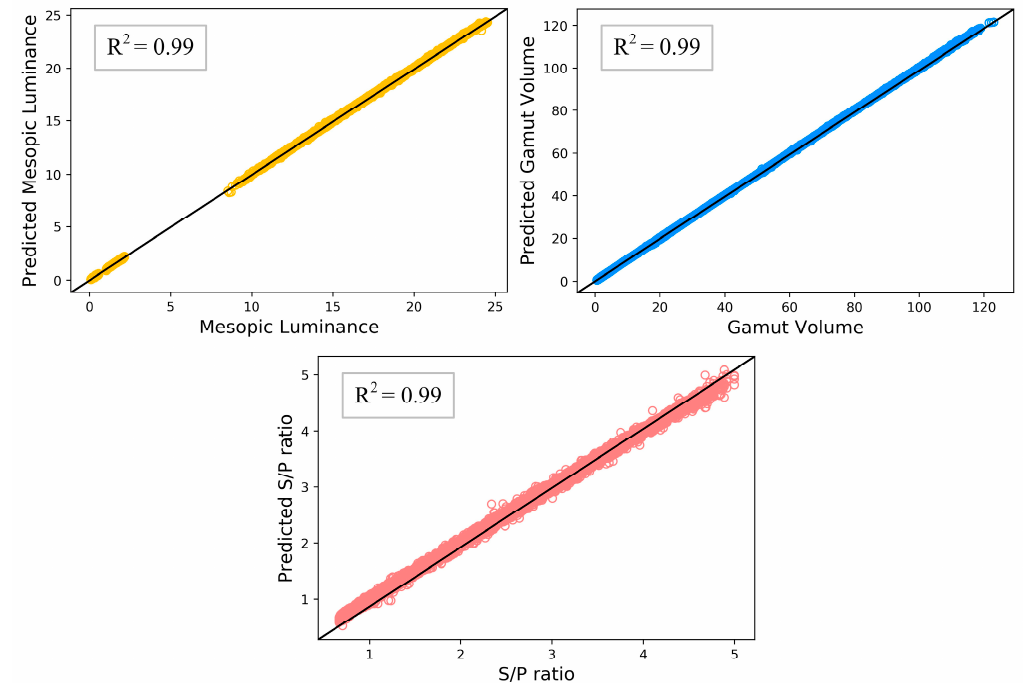
Figure 10. Scatter plots of the predictions.